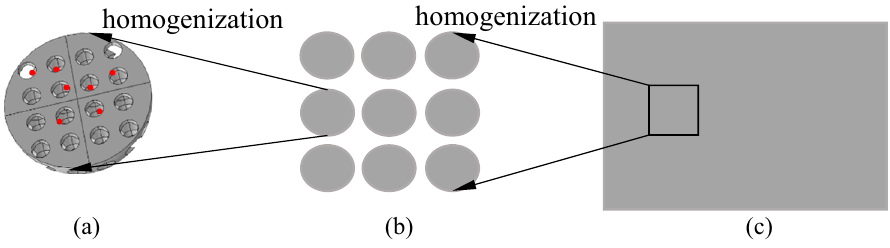
Figure 4. ( a ) The microstructure particles of the sensor material and the reaction site attached on it. ( b ) The accumulation of MOS nanoparticles after homogenization. ( c ) Further homogenization of the material macroscopic